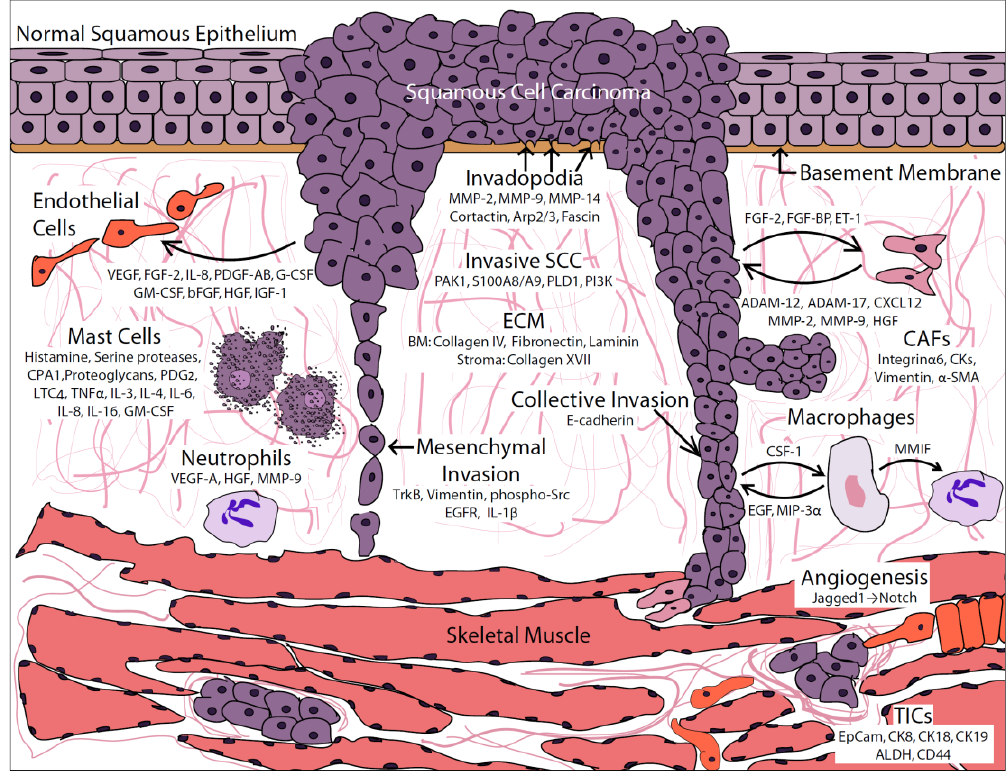
Figure 1. Diagram of tumor and stromal-based contributions that promote head and neck squamous cell carcinoma (HNSCC) invasion. Depicted is an invasive HNSCC tumor cell mass invading into the surrounding stroma and muscle tissue of the oral tongue. Specific cell types and their respective secreted protein contributions are detailed, demonstrating subsequent cellular responses and paracrine signaling networks. See text for additional